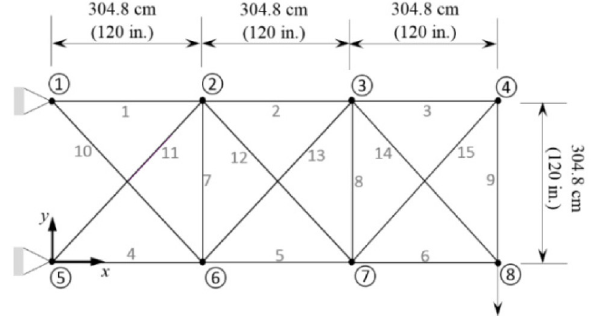
Fig. 2. Schematic of the planar 15-bar truss structure